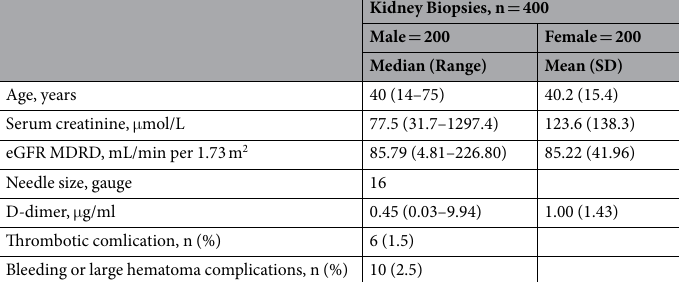
Table 1. Baseline Data of All Kidney Biopsies.